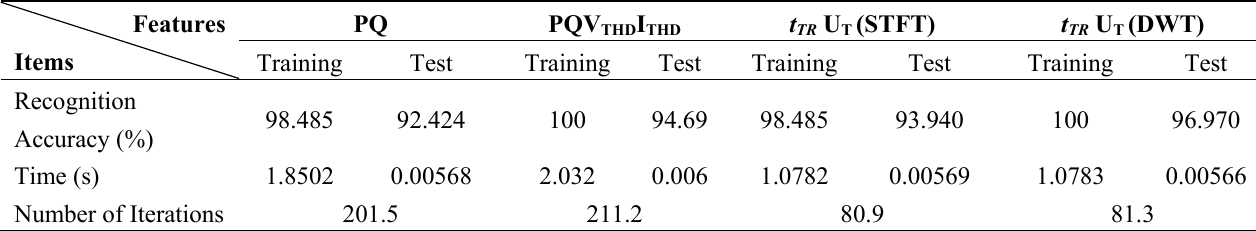
Table 3. The results of load identification in Case Study